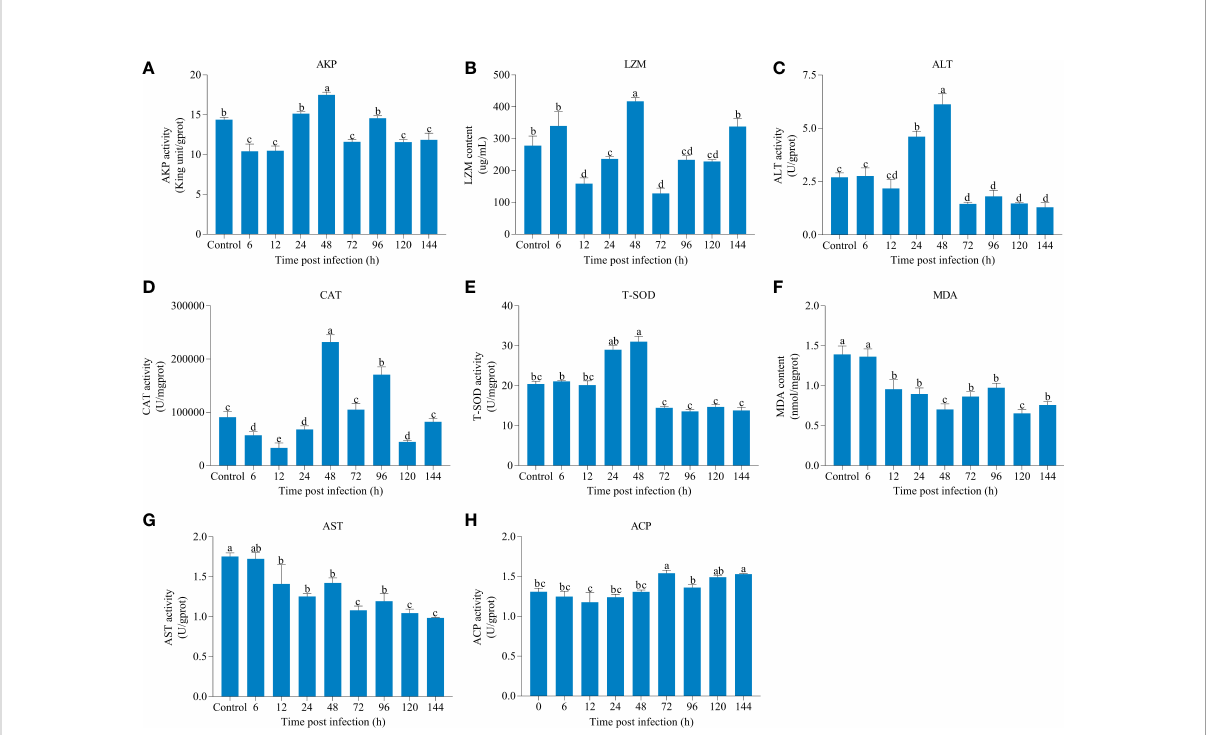
FIGURE 1 The changes of immune parameters of liver over different periods after infectious hematopoietic necrosis virus (IHNV) infection. (A) Alkaline phosphatase (AKP). (B) Lysozyme (LZM). (C) Alanine aminotransferase (ALT). (D) Catalase (CAT). (E) Total superoxide dismutase (T-SOD). (F) Malondialdehyde (MDA). (G) Aspartate aminotransferase (AST). (H) Acid phosphatase (ACP). The different lowercase letters above the bars represent signi fi cant differences ( P <